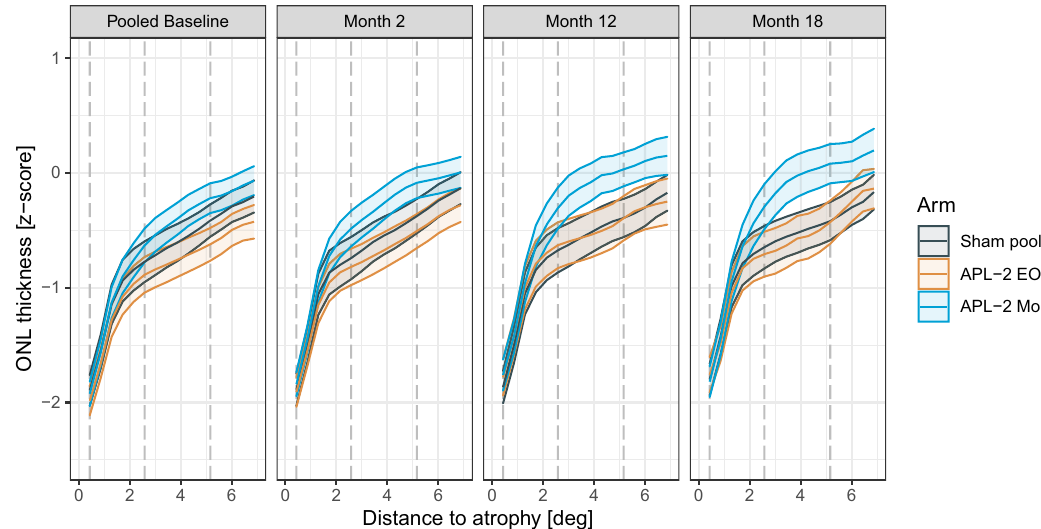
Figure 2. Change in thickness at the level of the outer nuclear layer (ONL) over time. The plots show the average thickness at the level of the outer nuclear layer (ONL, y-axis) and the standard error of the mean (SEM, ribbons) with the distance to the boundary of retinal pigment epithelium (RPE) atrophy (x-axis). The panels indicate the visit, and the color indicates the treatment arm. The vertical dashed lines denote the 0.43°, 2.58°, and 5.16° contour-lines that were considered for the linear mixed model analyses. Please note that the baseline junctional-zone ONL thickness differed slightly among the groups. The actual contrasts (i.e., change-over-time from baseline) are shown in Fig. 3. The data were derived from the modified intention-to-treat (mITT) analysis (N